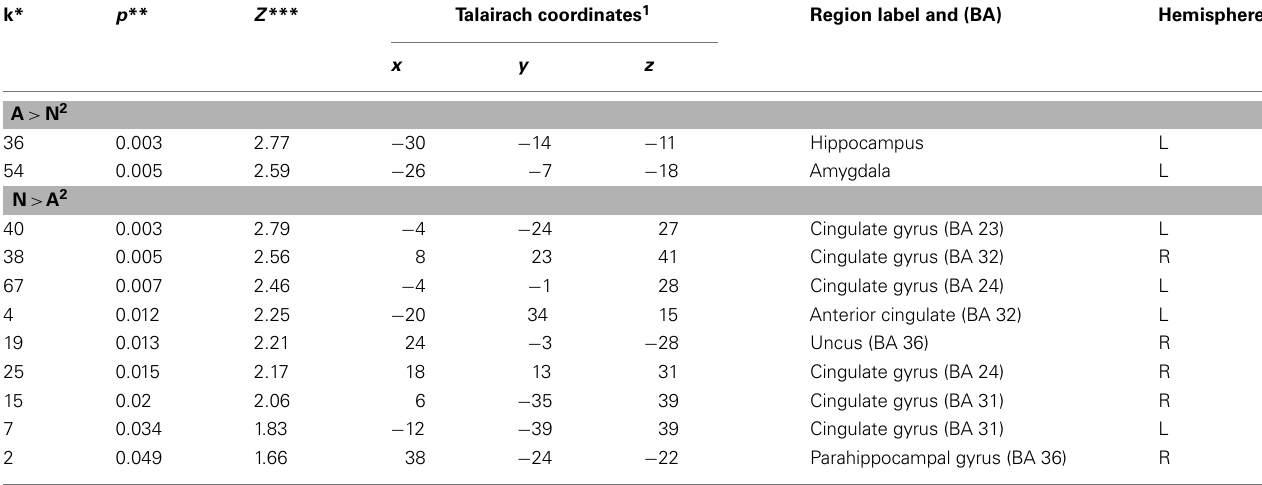
Table 5 | Exposure of alcohol and control condition – conjunction